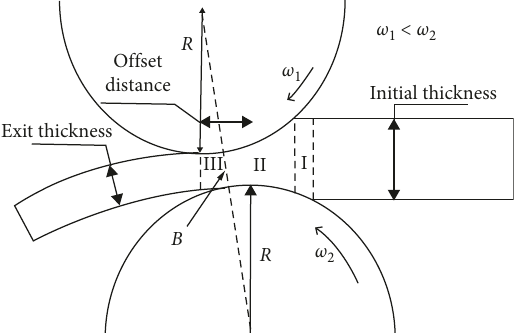
Figure 2: Schematic diagram of the deformation zone divided by contact conditions and the shortest distance between two